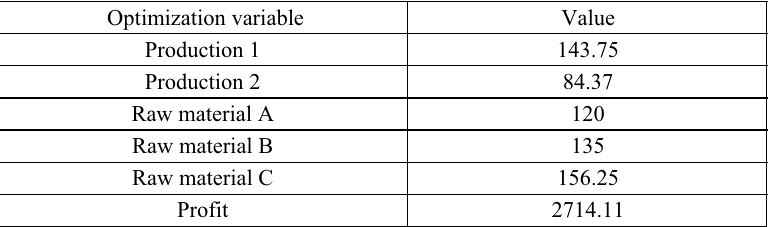
Table 4. Integrated MINLP profit results.